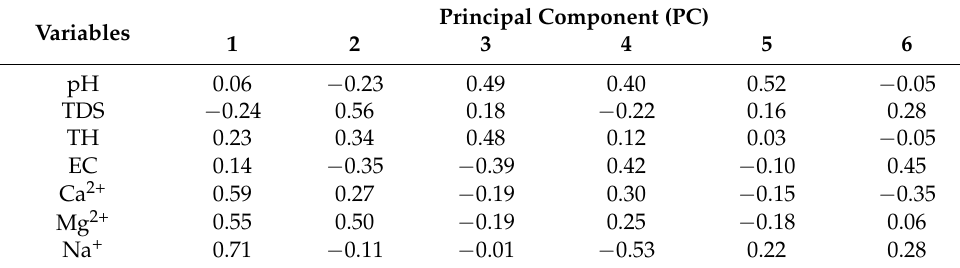
Table 5. Principal component analysis of groundwater